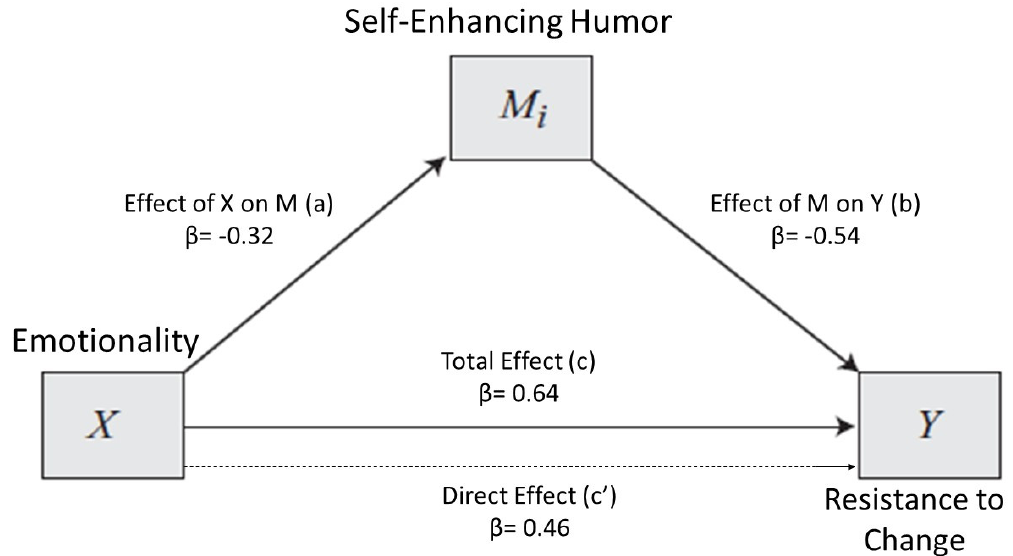
Figure 1. Model 1. Relationship between Emotionality and Resistance to Change, with Self-Enhancing Humor as a mediator. k² mediator effect size = 0.10. Table 3. Model 1. Mediation analysis statistics. In the upper part of the table, the indexes related to each regression analysis needed for testing the mediational model are summarized. In the lower part, the coefficients for each path of the mediation model are provided.